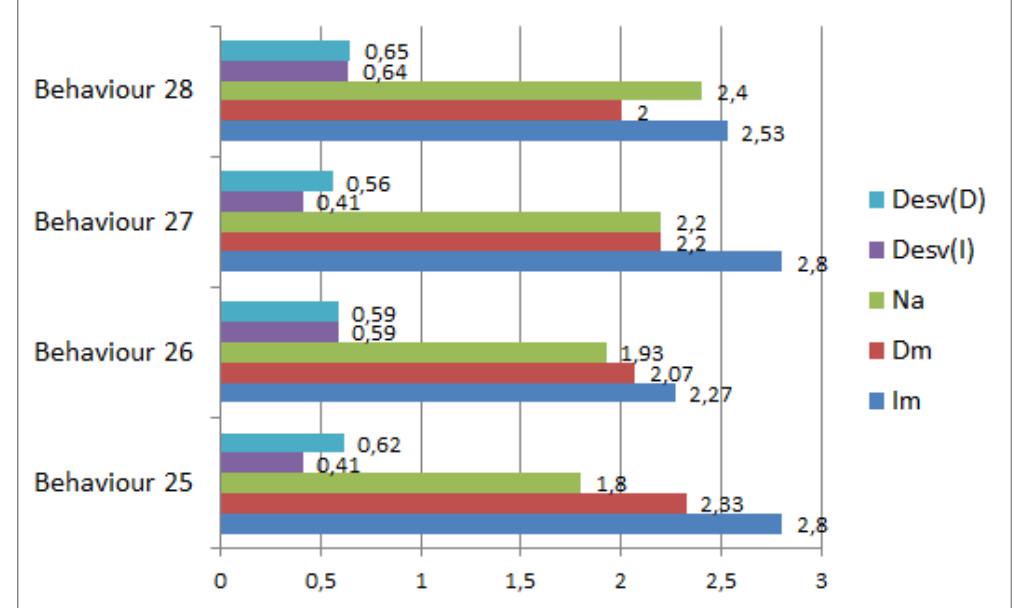
Figure 6. Requests, offers and